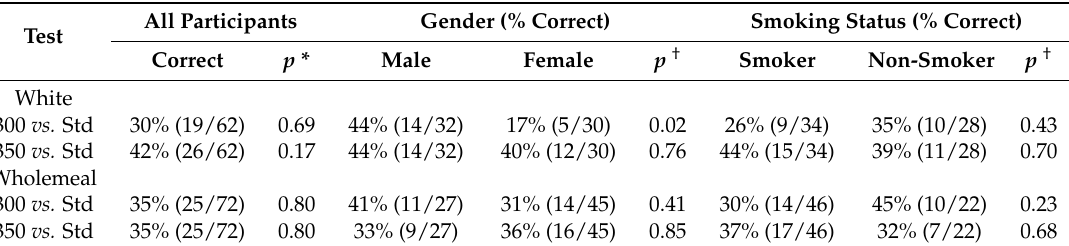
Table 2. Difference testing results.